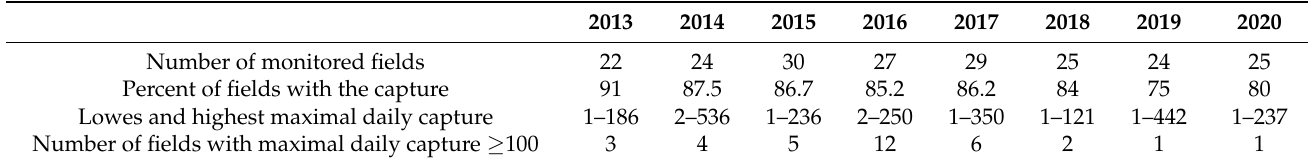
Table 2. The analysis of the WCR monitoring activities in Serbia in the period from 2013 until 2020 (data available at Portal izveštajno prognozne službe zaštite bilja [264]).